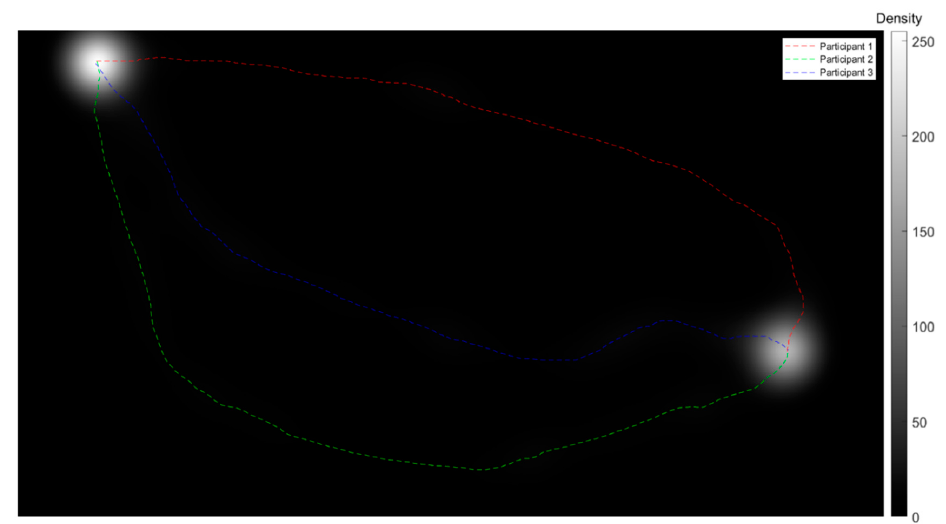
Figure 10. Generated mouse trajectories for the three participants case study superimposed on top of the calculated grayscale statistical heatmap.